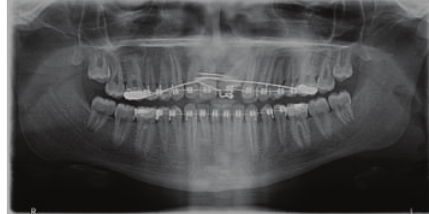
Figure 9: Follow-up panoramic radiograph depicting erupted maxillary central